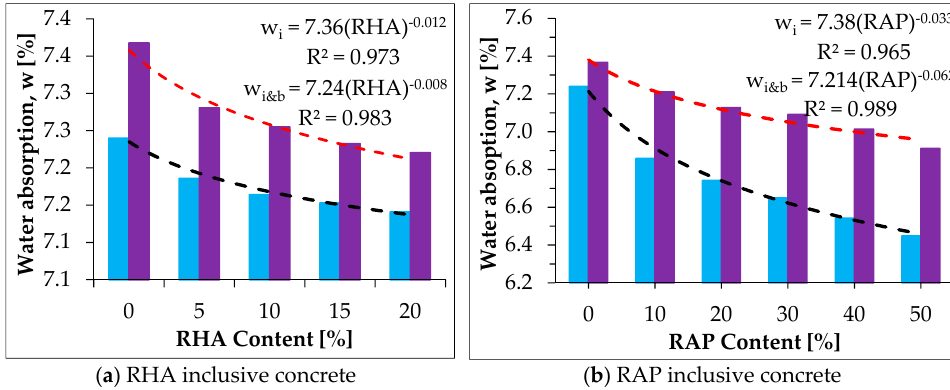
Figure 15. Water absorption by RHA and RAP concrete.